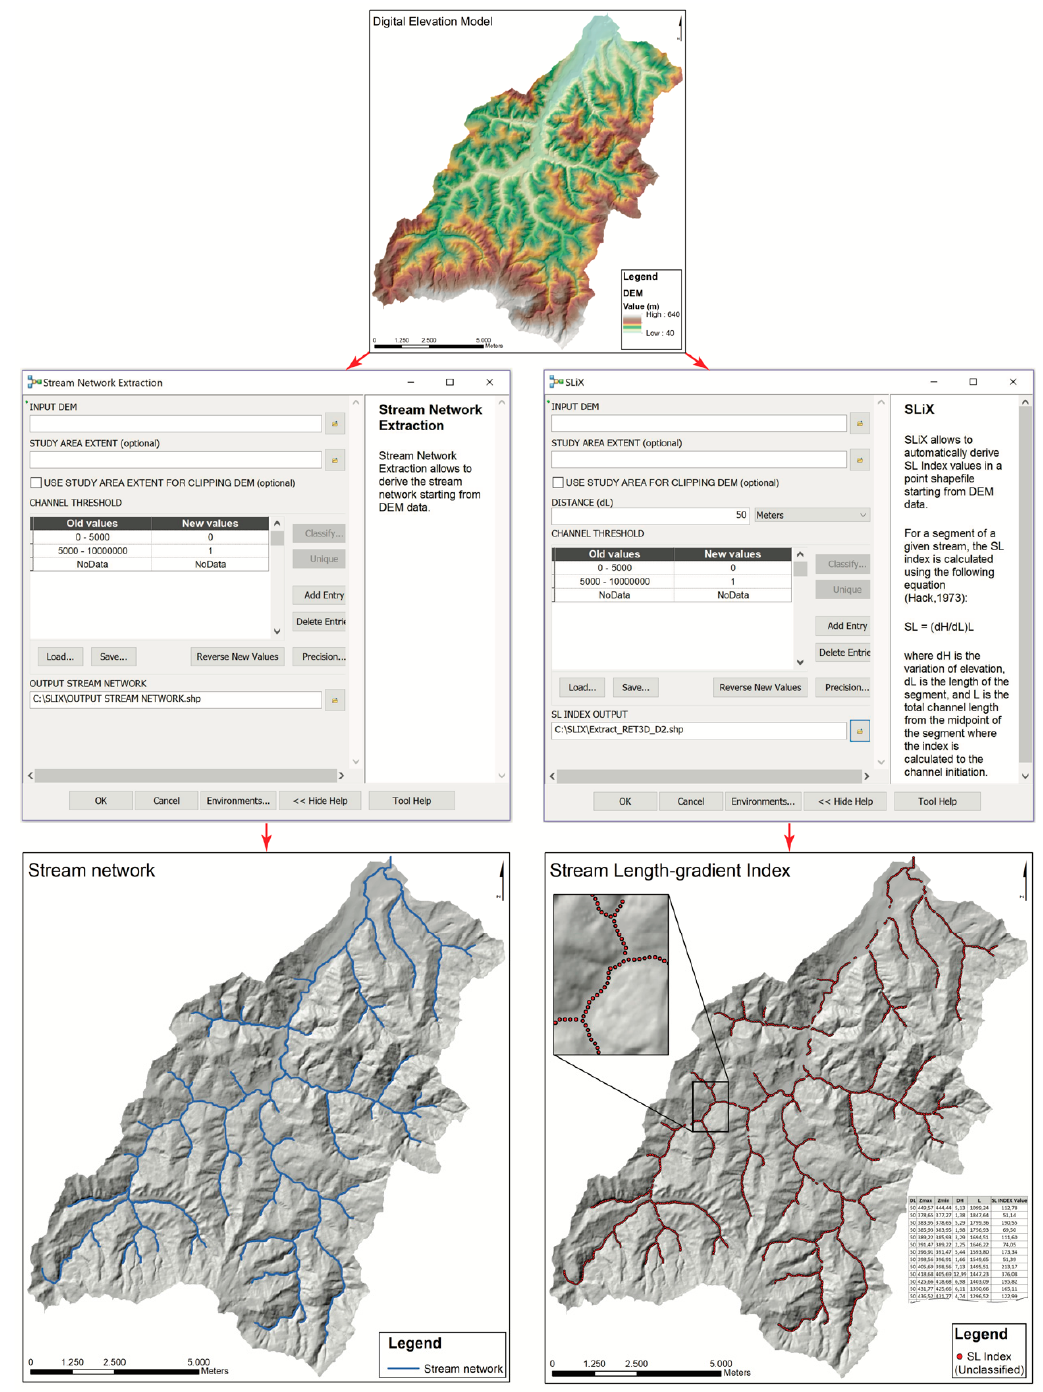
Figure 3. Stream Network Extraction model tool and SLiX tool in the SLiX toolbox. The Digital Elevation Model (DEM) represents the input data in both model tools. The Stream Network Extraction model allows deriving the drainage network (figure on the left), whereas the SLiX model allows the SL index values (figure on the right) to be derived.